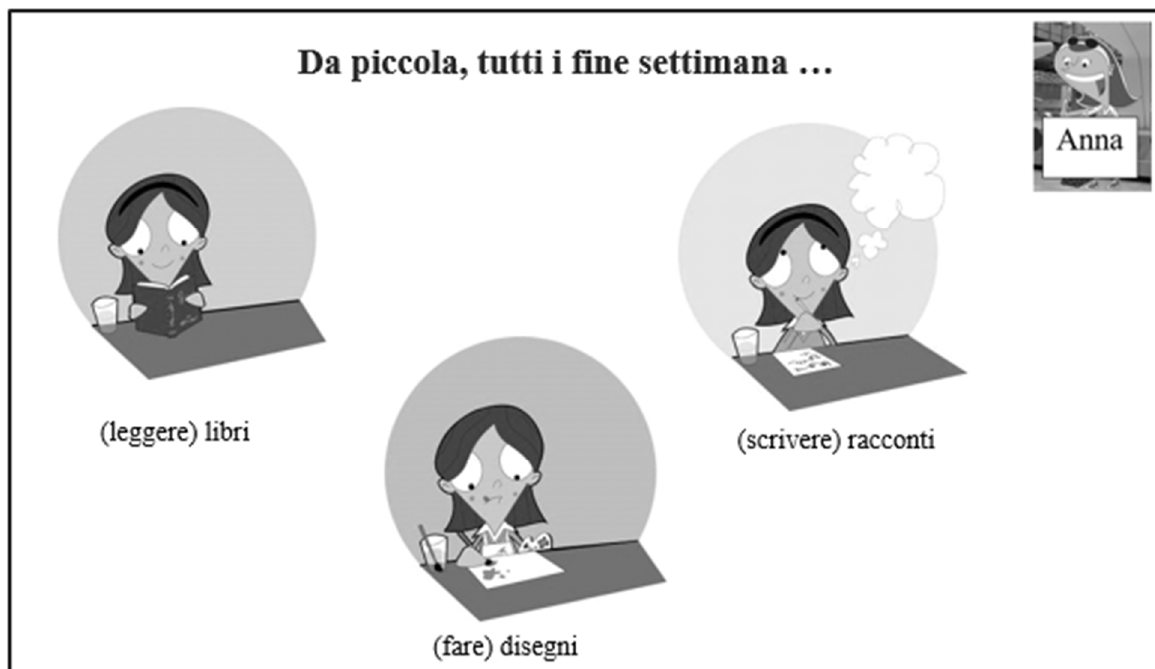
Figure A2. Example of Imperfective Habitual Context from the “Sisters’